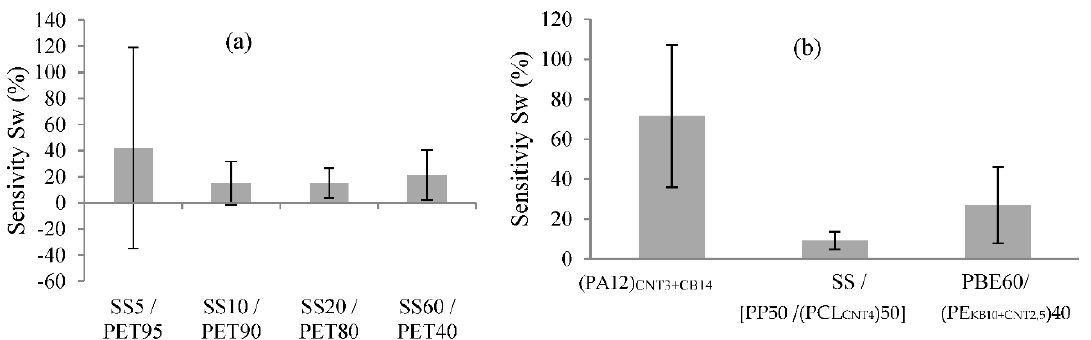
Figure 9. Principle of absorption—properties influence the following: ( a ) proportions by weight of an SS/PET yarn and ( b ) formulation of the CPC.